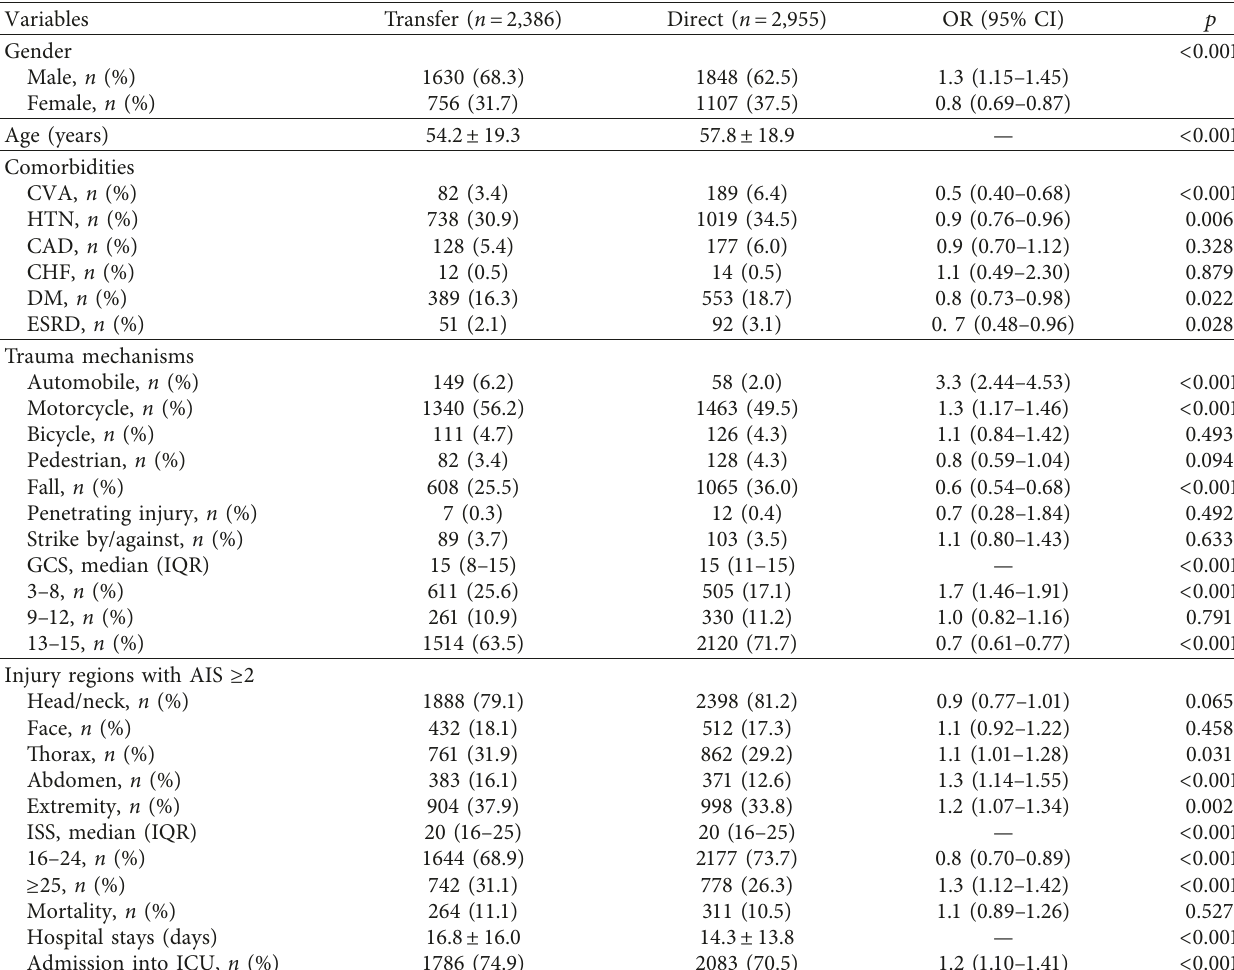
Table 1: Demographic and injury characteristics of the trauma patients with injury severity score equal to or more than 16.